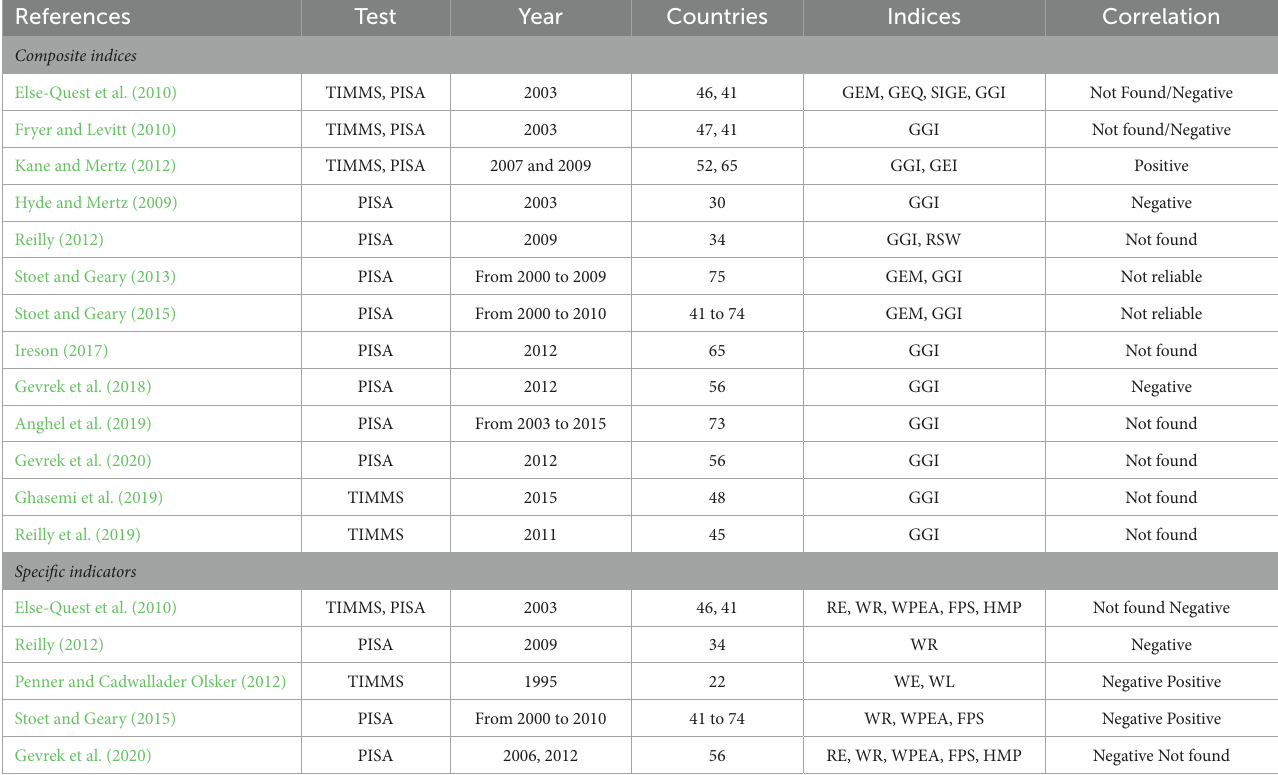
TABLE 1 Correlations between mathematics gender differences (men > women) and both composite indices and specific indicators of gender